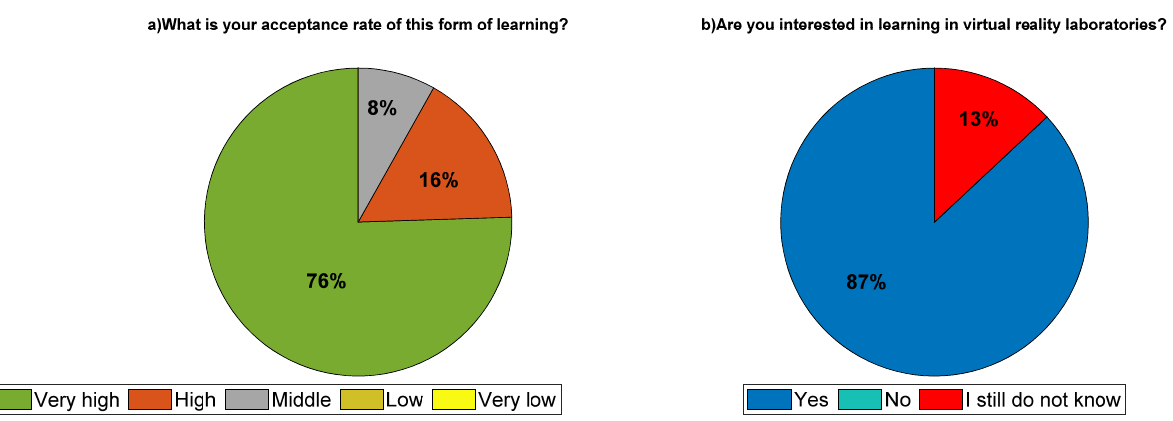
Figure 11. Questions regarding the performance of the virtual biphasic separator. ( a ) Third question, regarding the use of the application. ( b ) Fifth question, regarding realism.